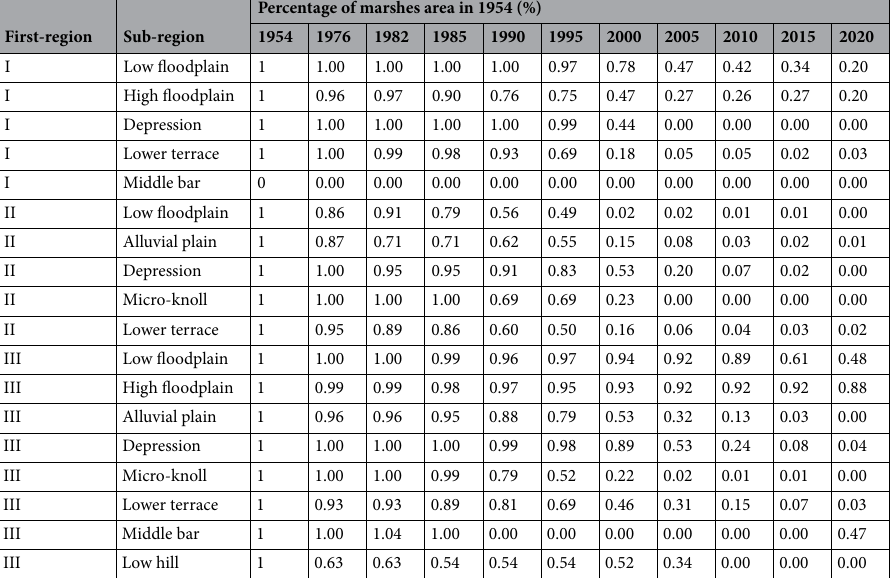
Table 6. The distribution of marsh during 1954–2020 based on geomorphic types in the first level